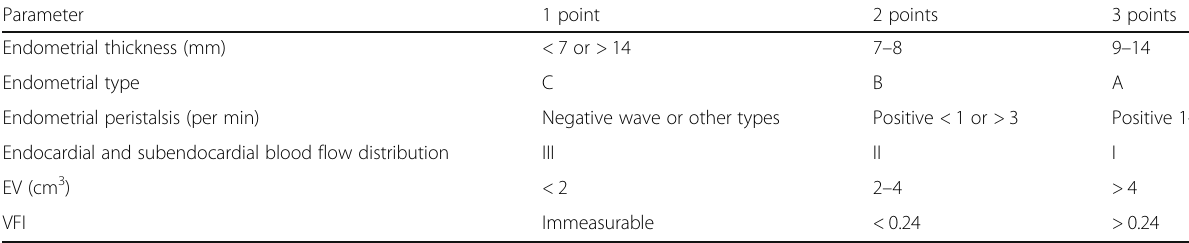
Table 1 Criteria for endometrial ultrasound scoring Parameter Endometrial thickness